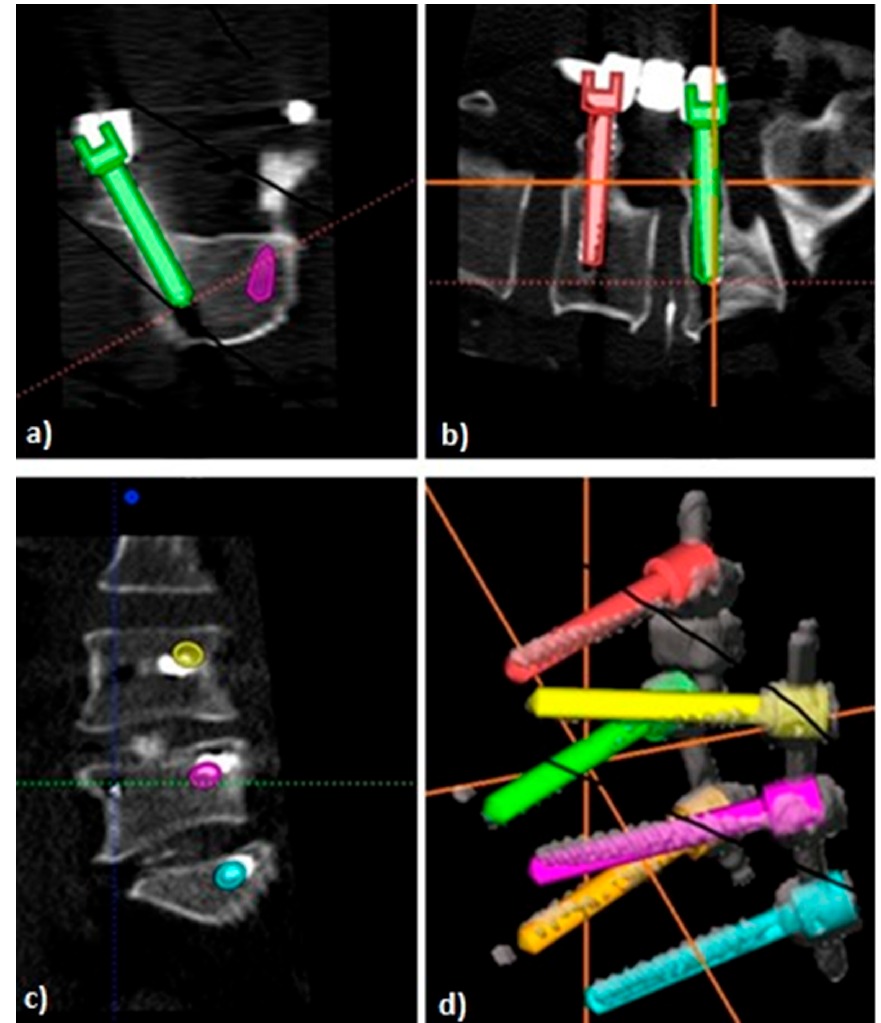
Figure 3. Illustration of superimposed screw positions for analysis of screw placement accuracy. Planned screw trajectories (colored screw illustrations) are superimposed on postoperative control-CT depicting final screw positions (white screw illustrations). Illustrations for transverse ( a ), sagittal ( b ), coronal ( c ) views and for 3D-reconstructions ( d ).